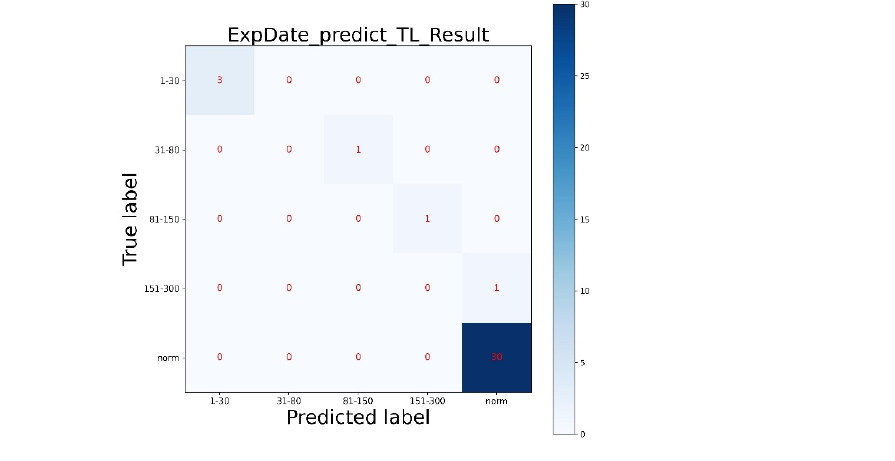
Figure 11. ResNet ‐ CNN model prediction results of ISC fault classification for the experimental bat ‐ Figure 11. ResNet-CNN model prediction results of ISC fault classification for the experimental tery data. battery data.